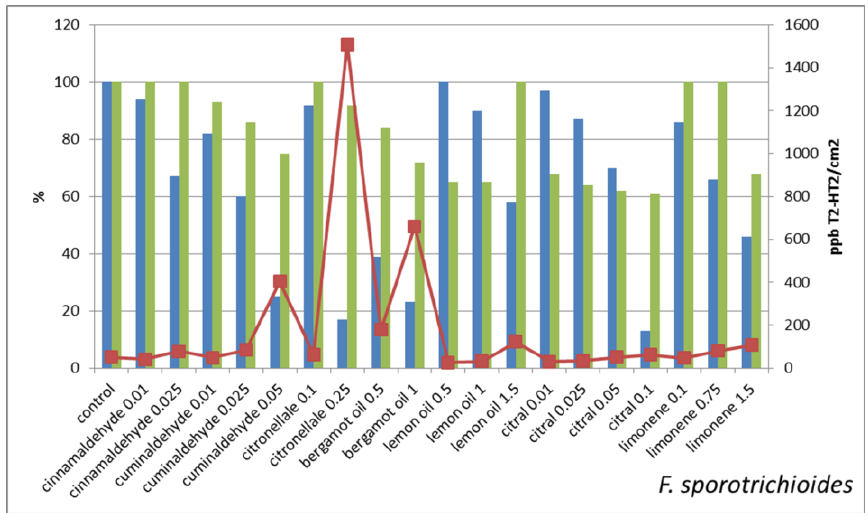
Figure 4. Impact of sub-lethal product concentrations on F. sporotrichioides growth and mycotoxin production. Blue bars indicate the mean values of mycelium in vitro growth (expressed as percentage of growth respect to untreated control) of Fusarium sporotrichioides treated with sub-lethal concentrations of the indicated natural products. Green bars represent the mycotoxin production (expressed as percentage of T-2, HT-2 respect to untreated control) and the line chart indicates the T-2, HT-2 concentration (expressed in ppb) per mycelium unit area (expressed in cm 2 ).